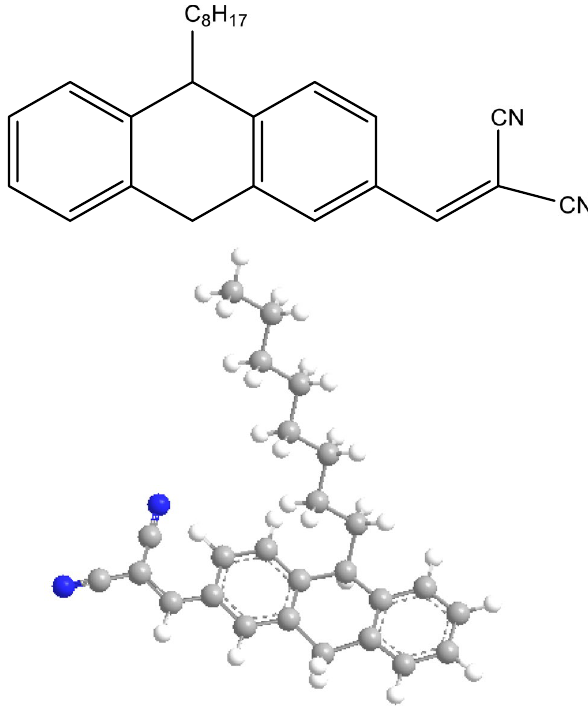
Figure 1. Chemical structure of synthesized PTZS-CN